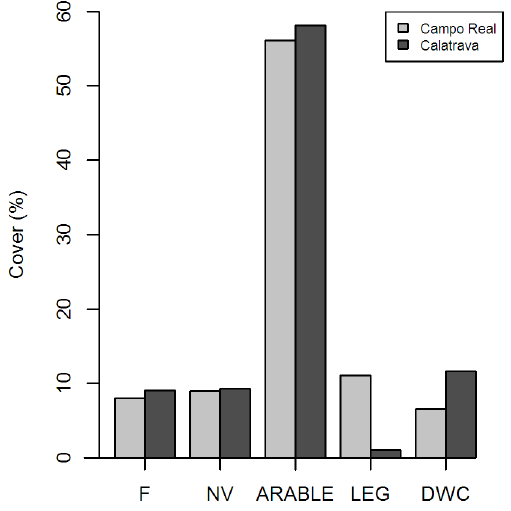
Figure 1. Land use cover in the study sites. Cover percentage of the land uses considered for Maxent modelling in 2011 in Campo Real and 2008 in Calatrava (F: short term fallows, NV: natural vegetation encompassing long term fallows and low height scrubs; Arable: cereal fields and ploughed lands; LEG: leguminous crops; DWC: dry woody